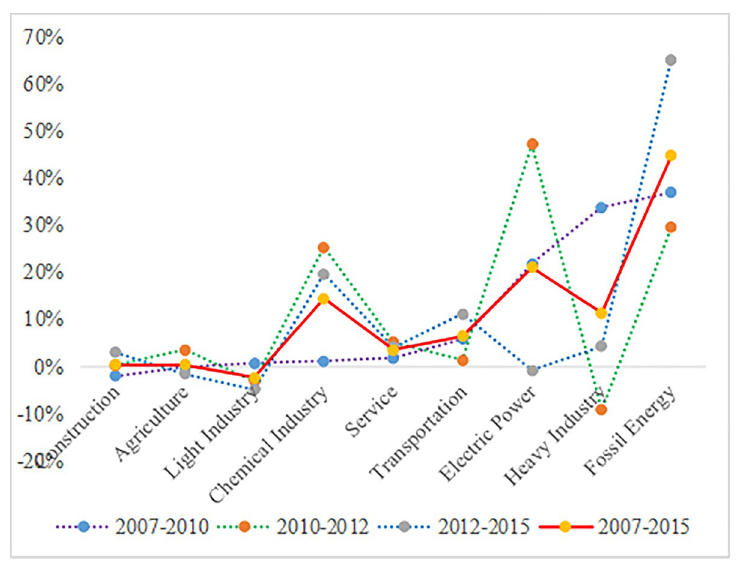
Fig 5. Contribution shares of various sectors to carbon emission growth from 2007 to